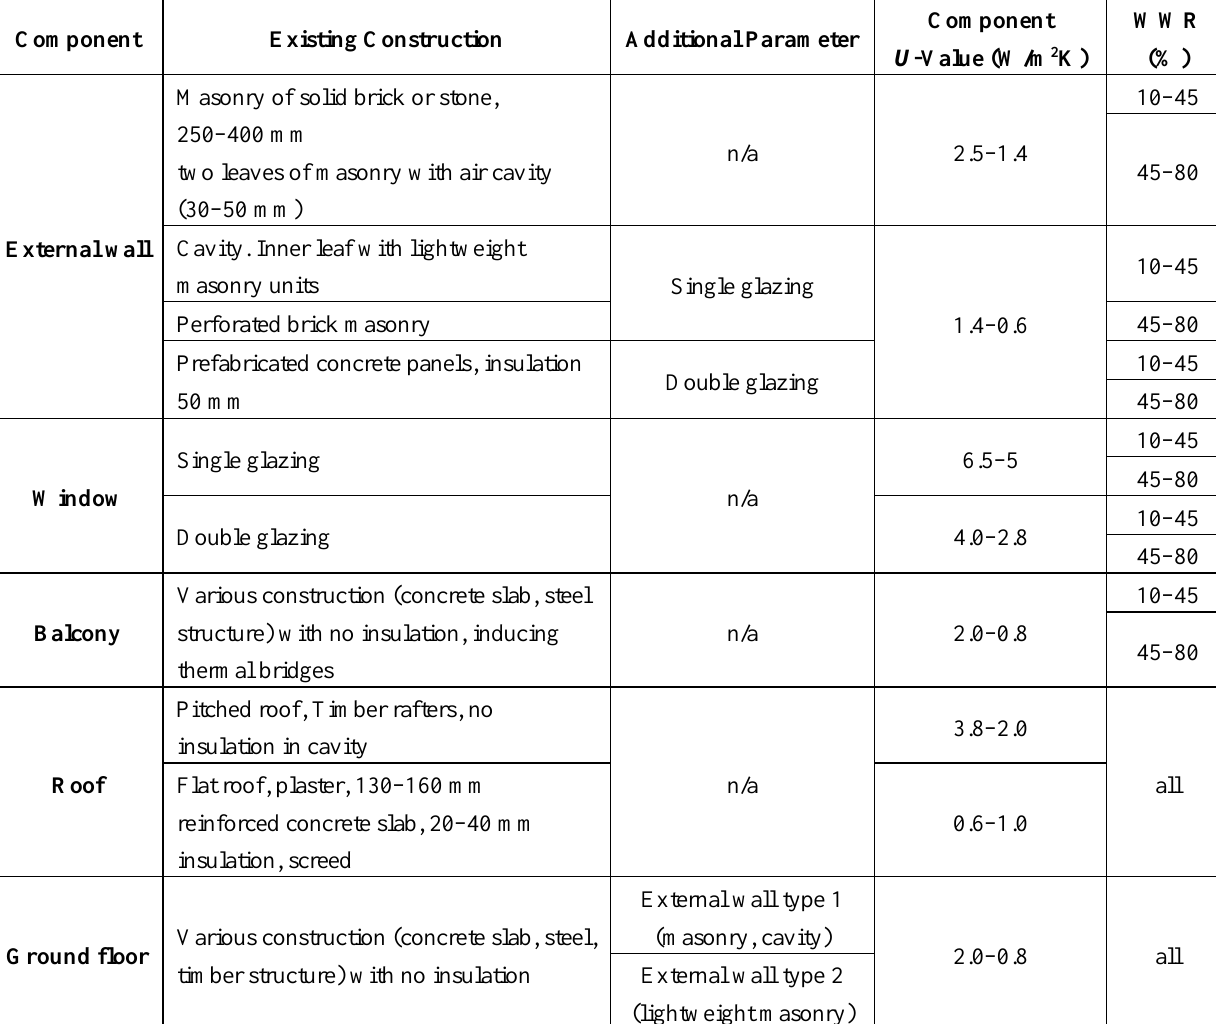
Table 3. Building construction characteristics to be considered for the association with toolbox calculation